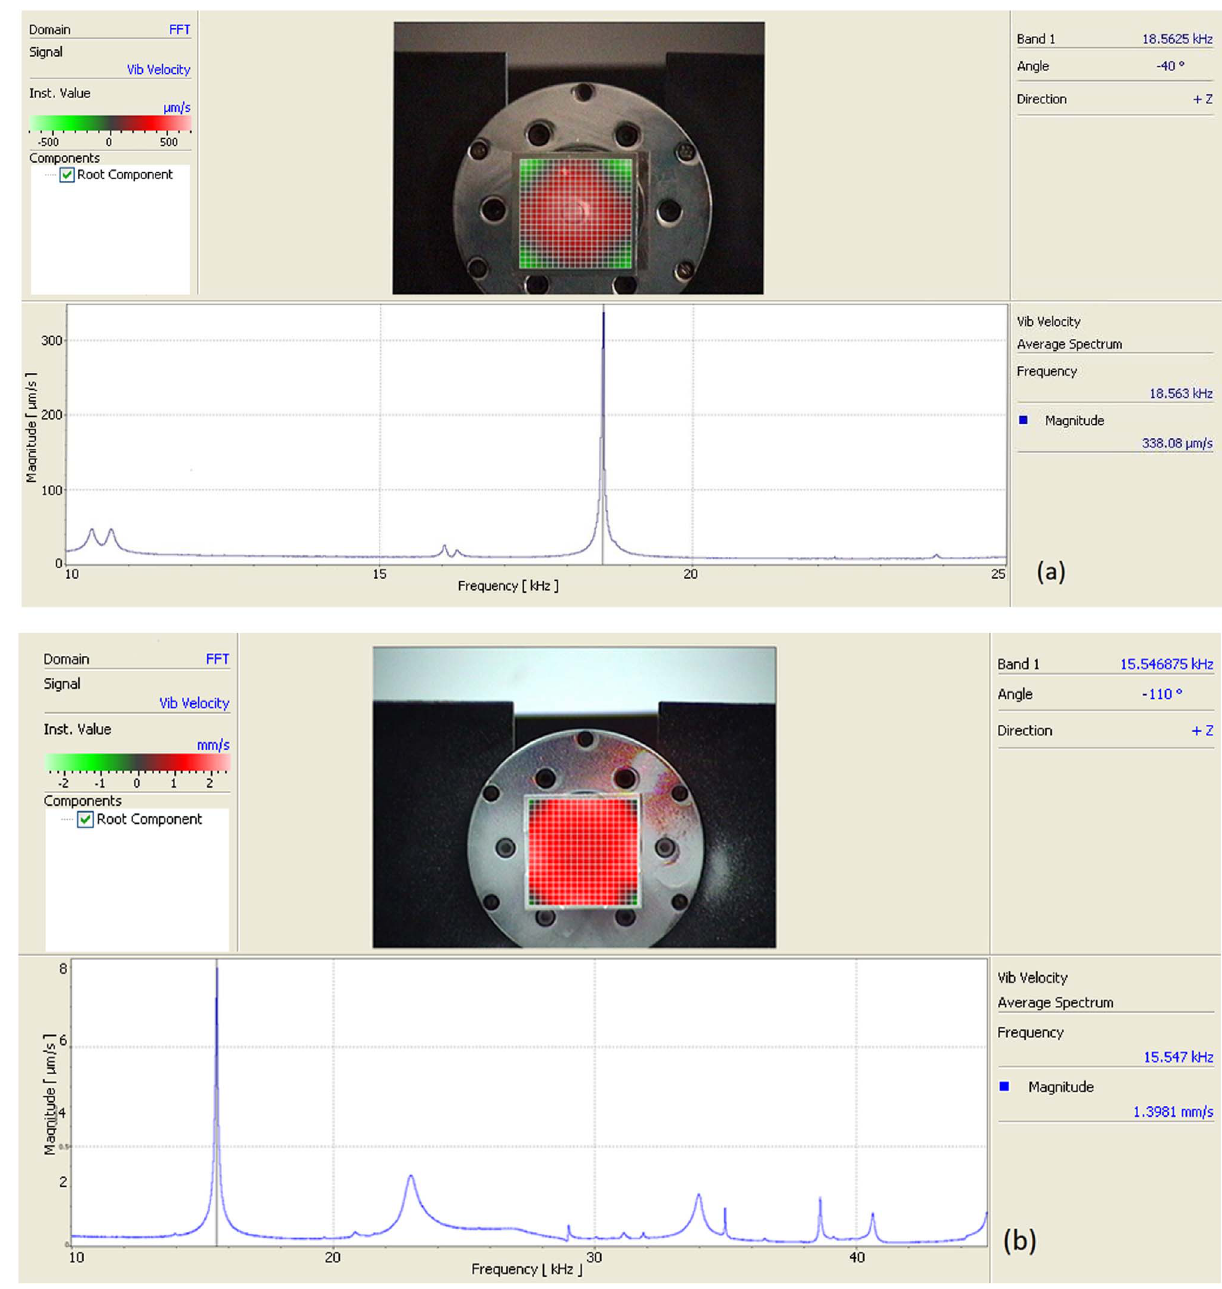
Figure 7. The vibration velocity spectra and the modes at the peak values of two radiators. (a) Radiator I, (b) Radiator